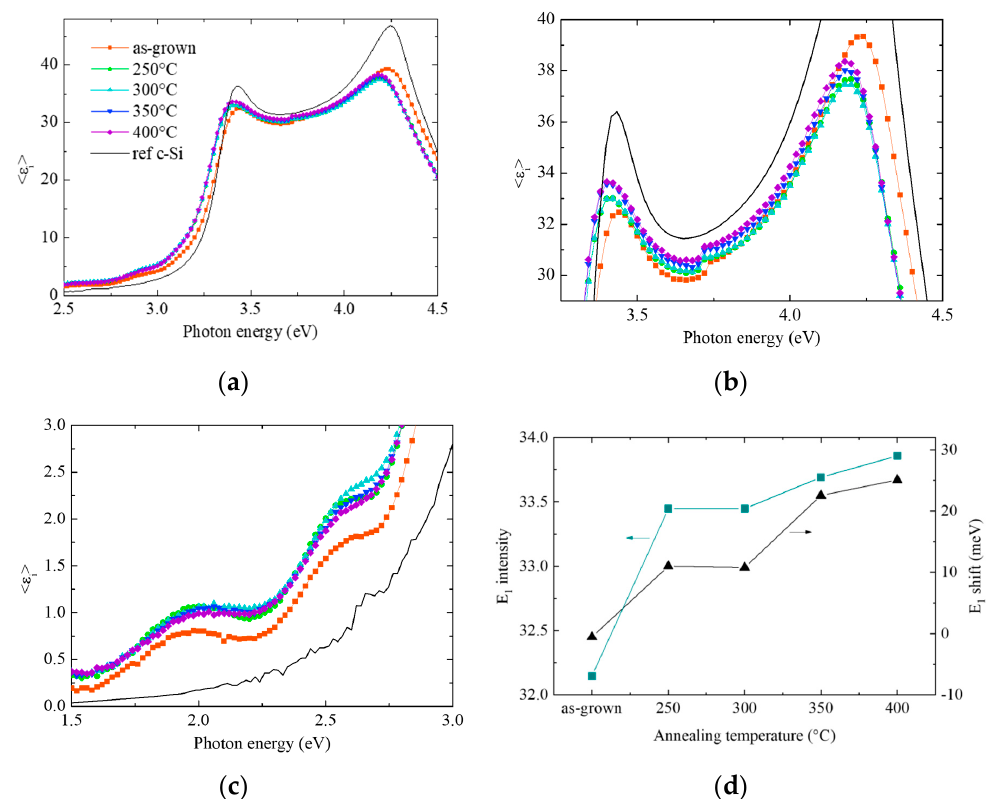
Figure 1. ( a ) Imaginary part of the pseudo-dielectric function of epi-Si layers as-grown and after annealing at temperatures from 250 to 400 ◦ C, and of a c-Si wafer as reference (black line) ( b ) Zoom-in on the two c-Si characteristic peaks E 1 and E 2 ( c ) Zoom-in on the interference fringes and ( d ) E 1 peak intensity (left) and shift (right) as compared to the position of the c-Si reference as functions of the annealing temperature.